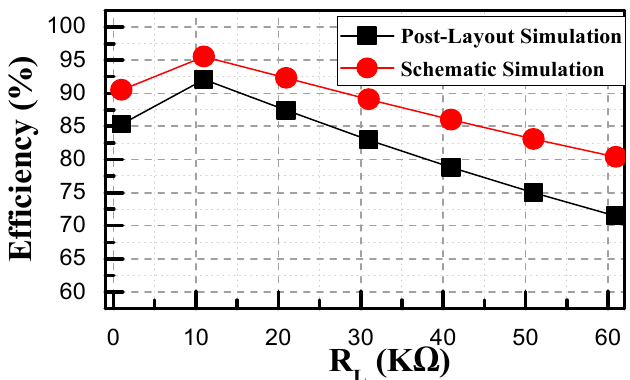
Figure 26. The post-layout simulation of the efficiency of the proposed SSC-DVS architecture versus the load resistor R L when V in =1.5 V, F SW = 50 MHz, C = 50 pF.